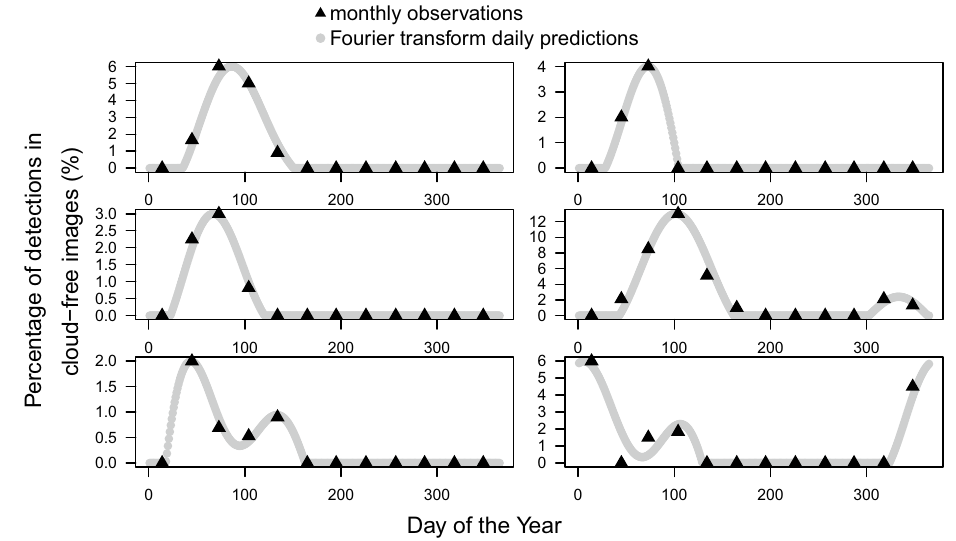
Figure 14. Examples of observed time series of detections in cloud-free images (%) and their daily estimation modeled using the Fourier